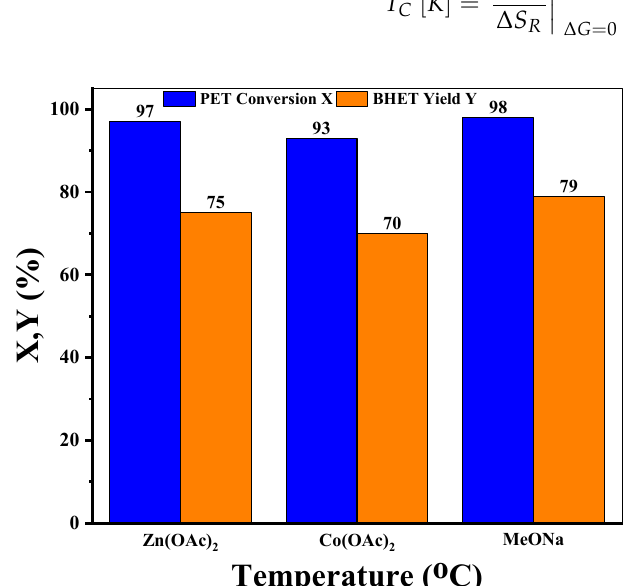
Figure 4. Performance comparison of MeONa with different catalysts.